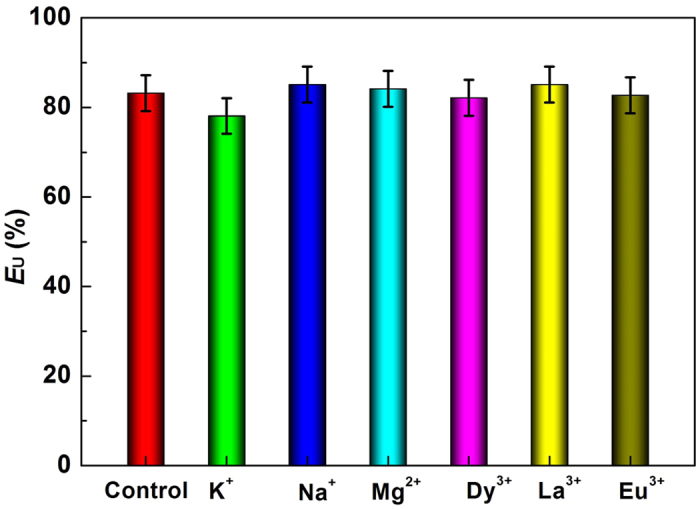
Influence of different metal ions on the extraction of UO22+.([UO22+] = 2 mM; [M] = 2 mM, M = K+, Na+, Mg2+, Dy3+, La3+, Eu3+).